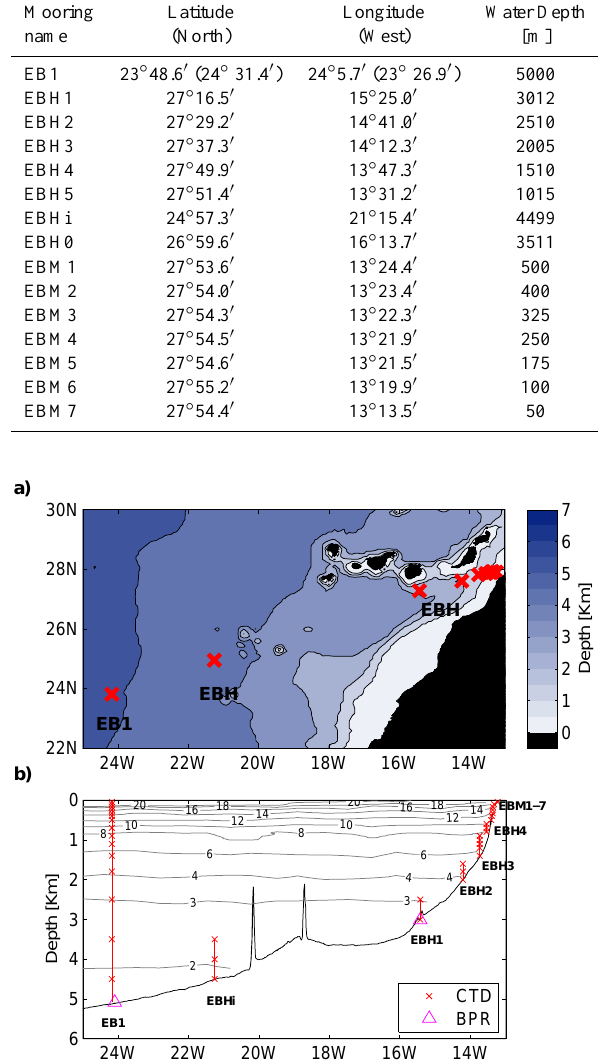
Fig. 2. (a) Location of the moorings near the eastern boundary of the 26.5 ◦ N section (red crosses), (b) distribution of CTD sensors and bottom pressure recorders (BPR) at the eastern boundary array as deployed for year 2007. The contours represent potential temper- ature in ◦ C from a CTD transatlantic section at a nominal latitude of 24.5 ◦ N carried out in year 2004.